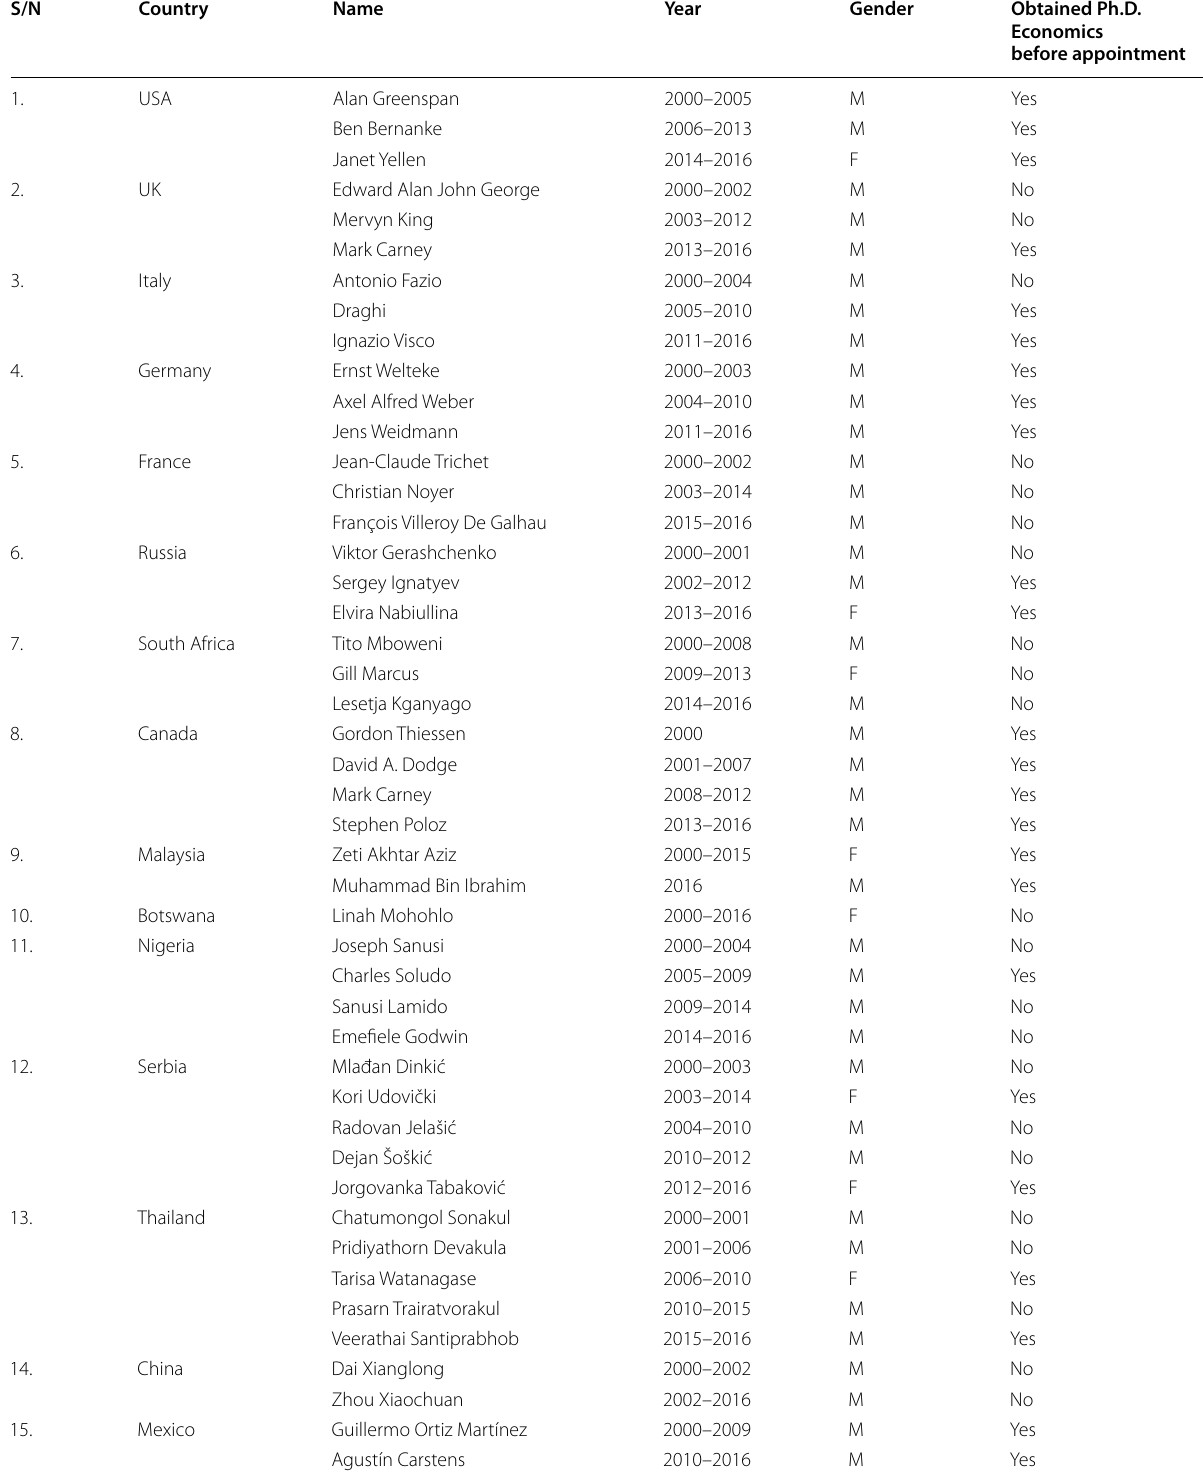
Table 1 Information on central bank